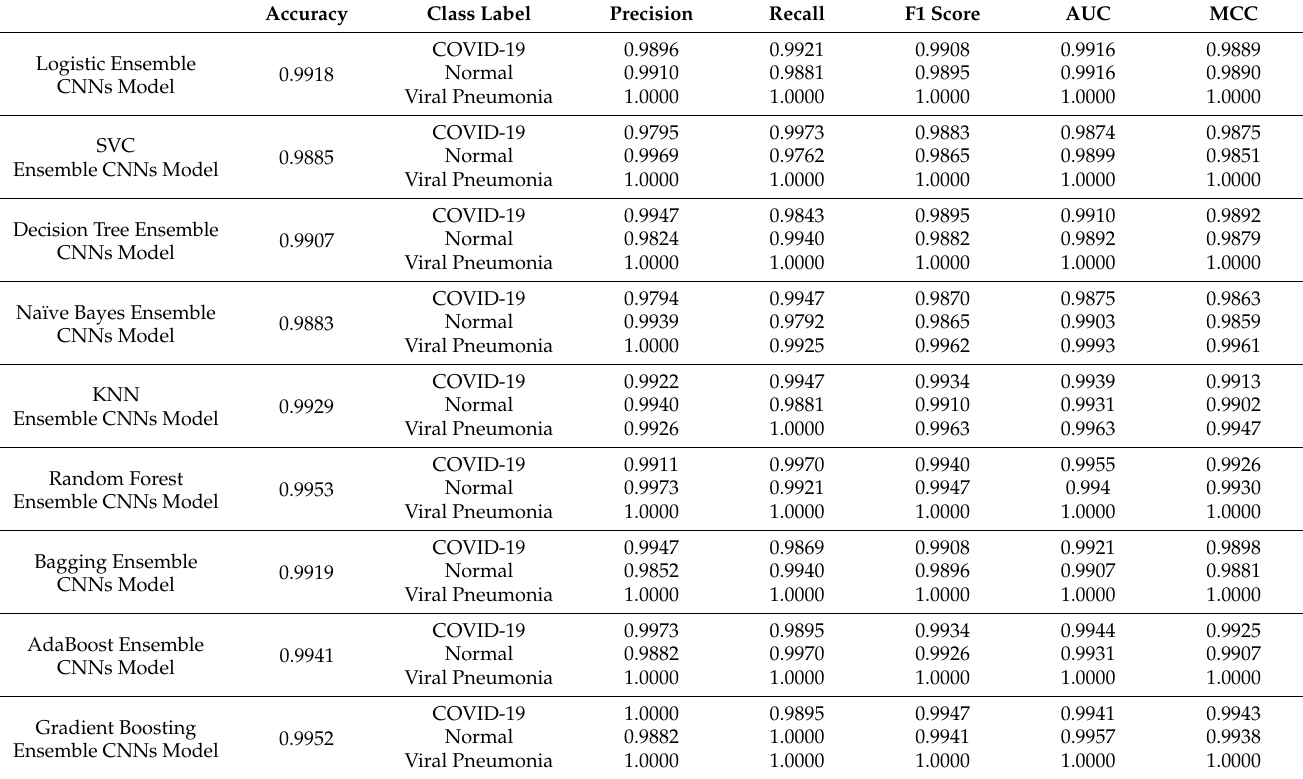
Table 4. Evaluation Metrics for Deep Ensemble Models using ML